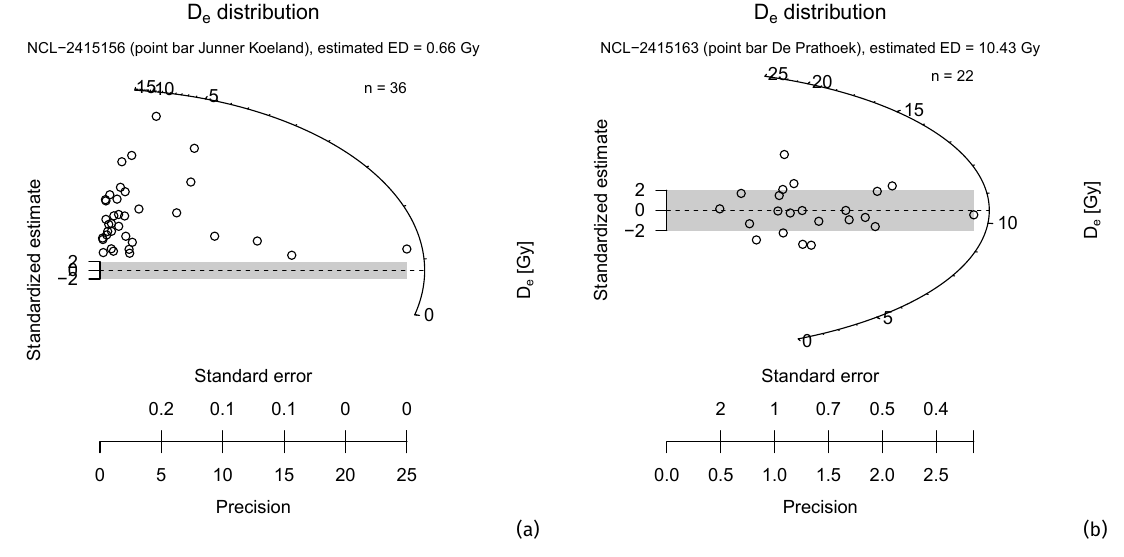
Figure 6. Two radial plot examples showing (a) a scroll bar sample (NCL-2415156) from Junner Koeland and (b) the sample collected in a terrace remnant near Prathoek (NCL-2415163). The scroll bar sample in panel (a) is poorly bleached, showing a large population of grains with a D e of about 10Gy. Such equivalent doses are similar to those of the terrace sample in panel (b) (CAM: D e 10 . 43 ± 0 .